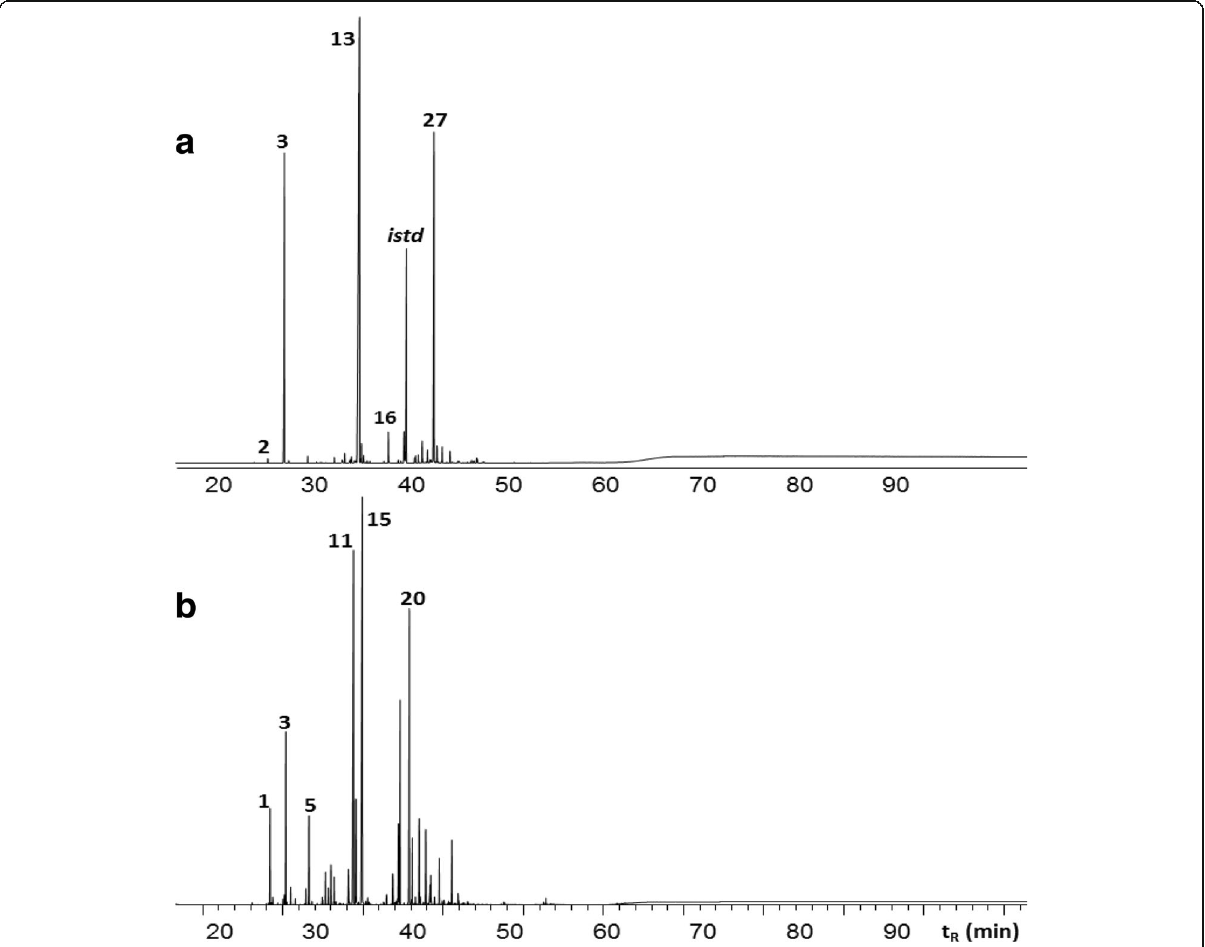
Fig. 1 Typical gas chromatography-mass spectrometry (GC-MS) profiles, in a DB-5 (60 m) column with a mass selective detector (EI. 70 eV), of essential oils obtained from Lippia alba Carvone ( a ) and Citral ( b ) chemotypes by microwave-assisted hydrodistillation (MWHD). The corresponding peak identification is showed in Table